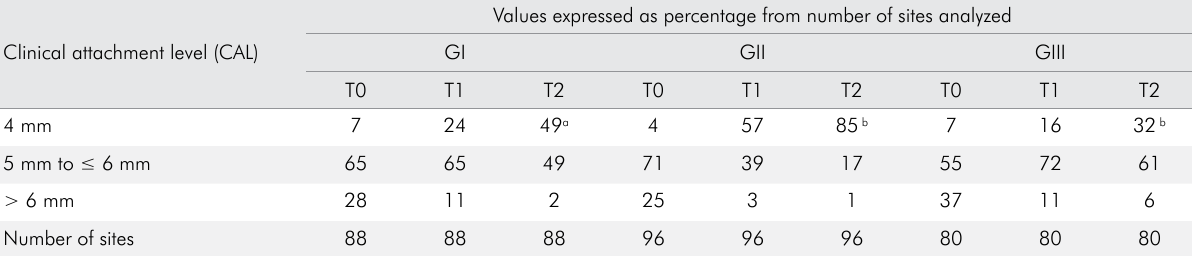
Table 4. Gain values obtained from CAL and evaluation by sites expressed as a percentage according to categories after treatment with 10% DOX gel and scaling and root planning (SRP) (G1), 10% DOX: β -cyclodextrin gel and SRP (GII) and SRP alone (GIII). Clinical attachment level